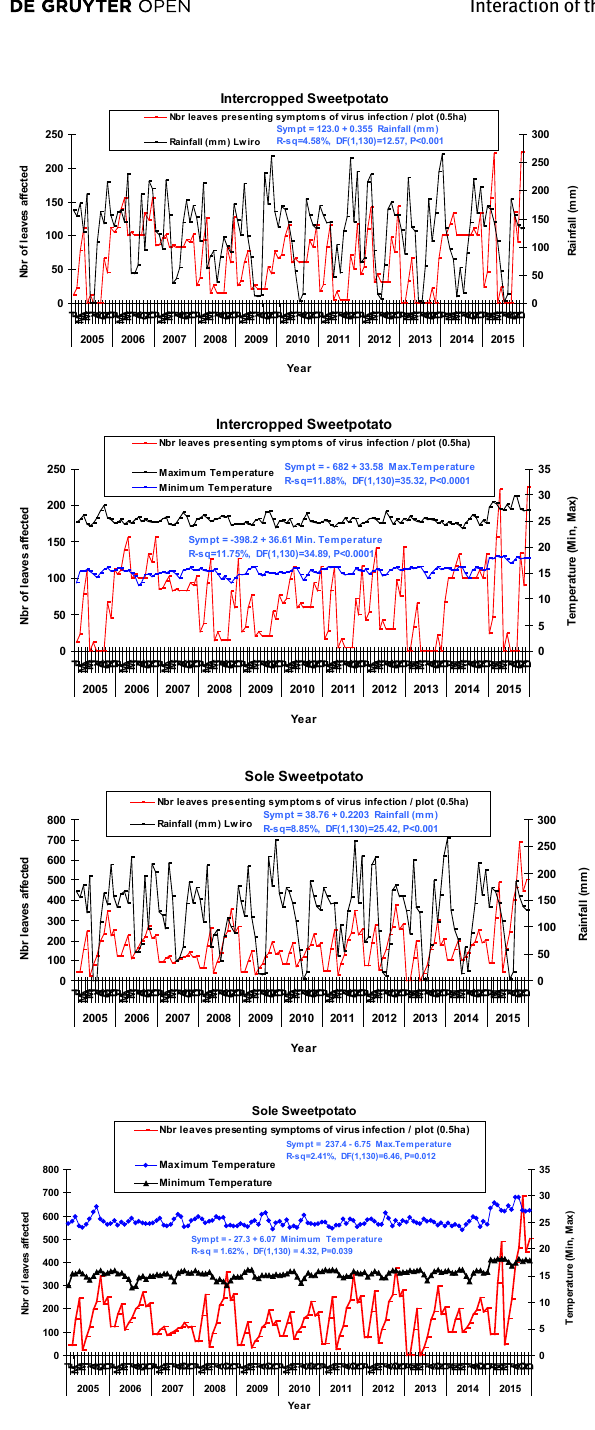
Figure 12: Fluctuation of the sweet potato virus disease pressure in relationship with variability in climatic factors (rainfall, temperature) under intercropping and mono-cropping systems in South-Kivu Province, eastern